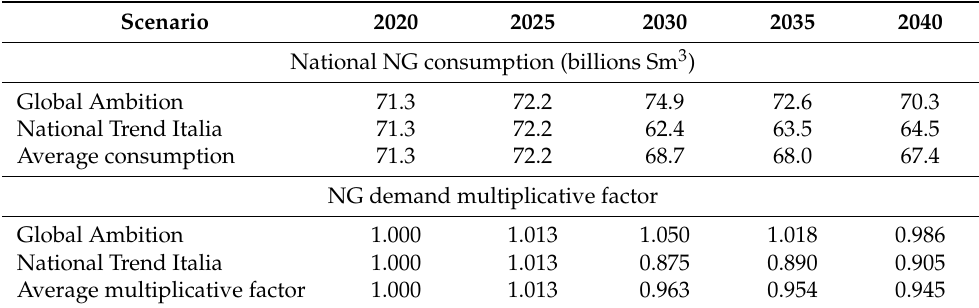
Table 3. NG demand forecast in Italy